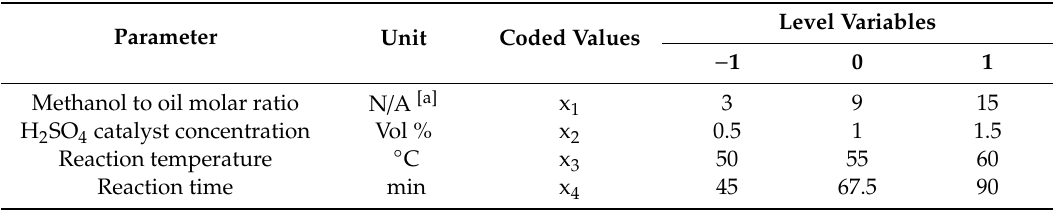
Table 3. Experimental ranges and levels of the independent variables in the Box–Behnken for esterification of crude C. manghas oil. Parameter Unit